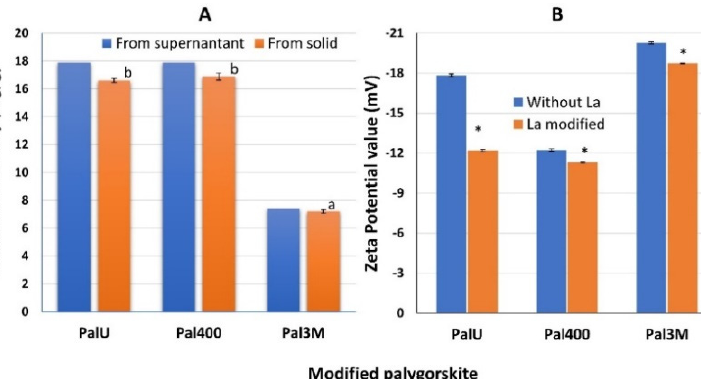
Figure 2. Amount of La on the raw and modified palygorskite ( A ). Only the solid samples were extracted in duplicate showing mean with the column bar and standard deviation with the error bar. The different letters on the top of the bar indicate a significant difference at 95% level of confidence. Also, the zeta potential of material before and after La treatment ( B ). The star (*) represents that the zeta value changes significantly from its parent material after La treatment.